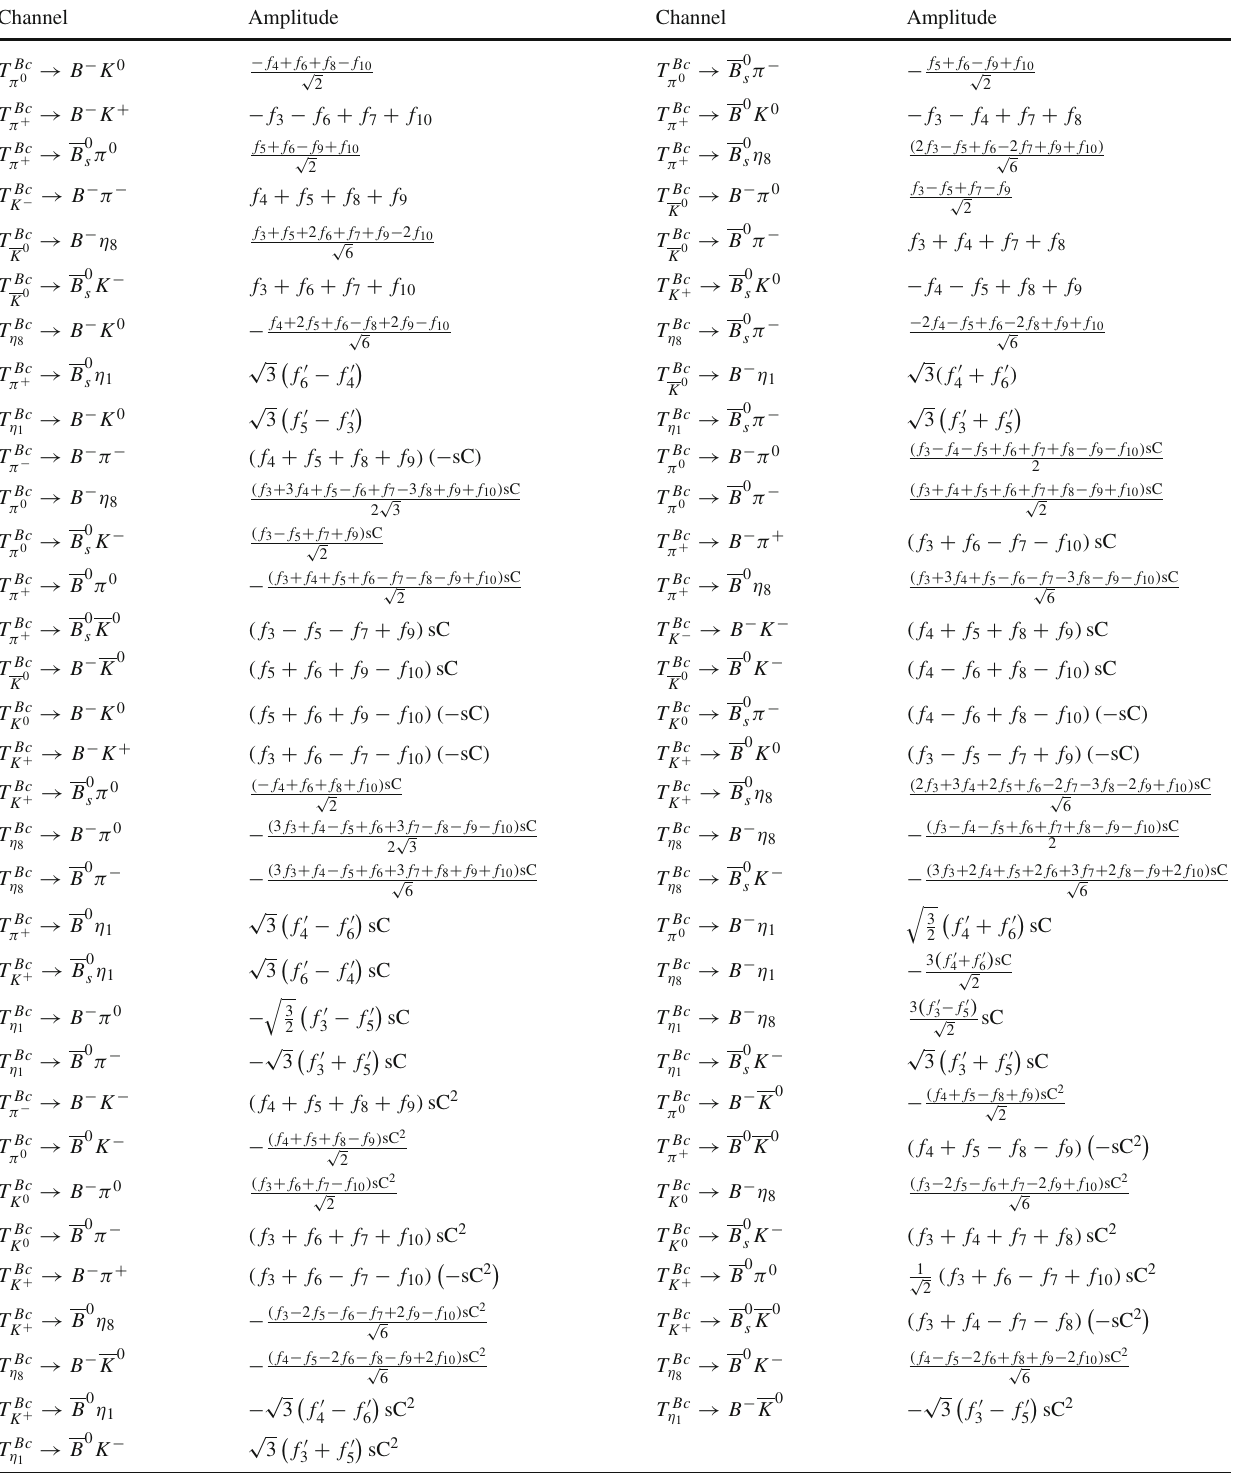
Table 8 Tetraquark T b ¯ c 8 / T b ¯ c 1 decays into a B meson and light meson Channel Amplitude